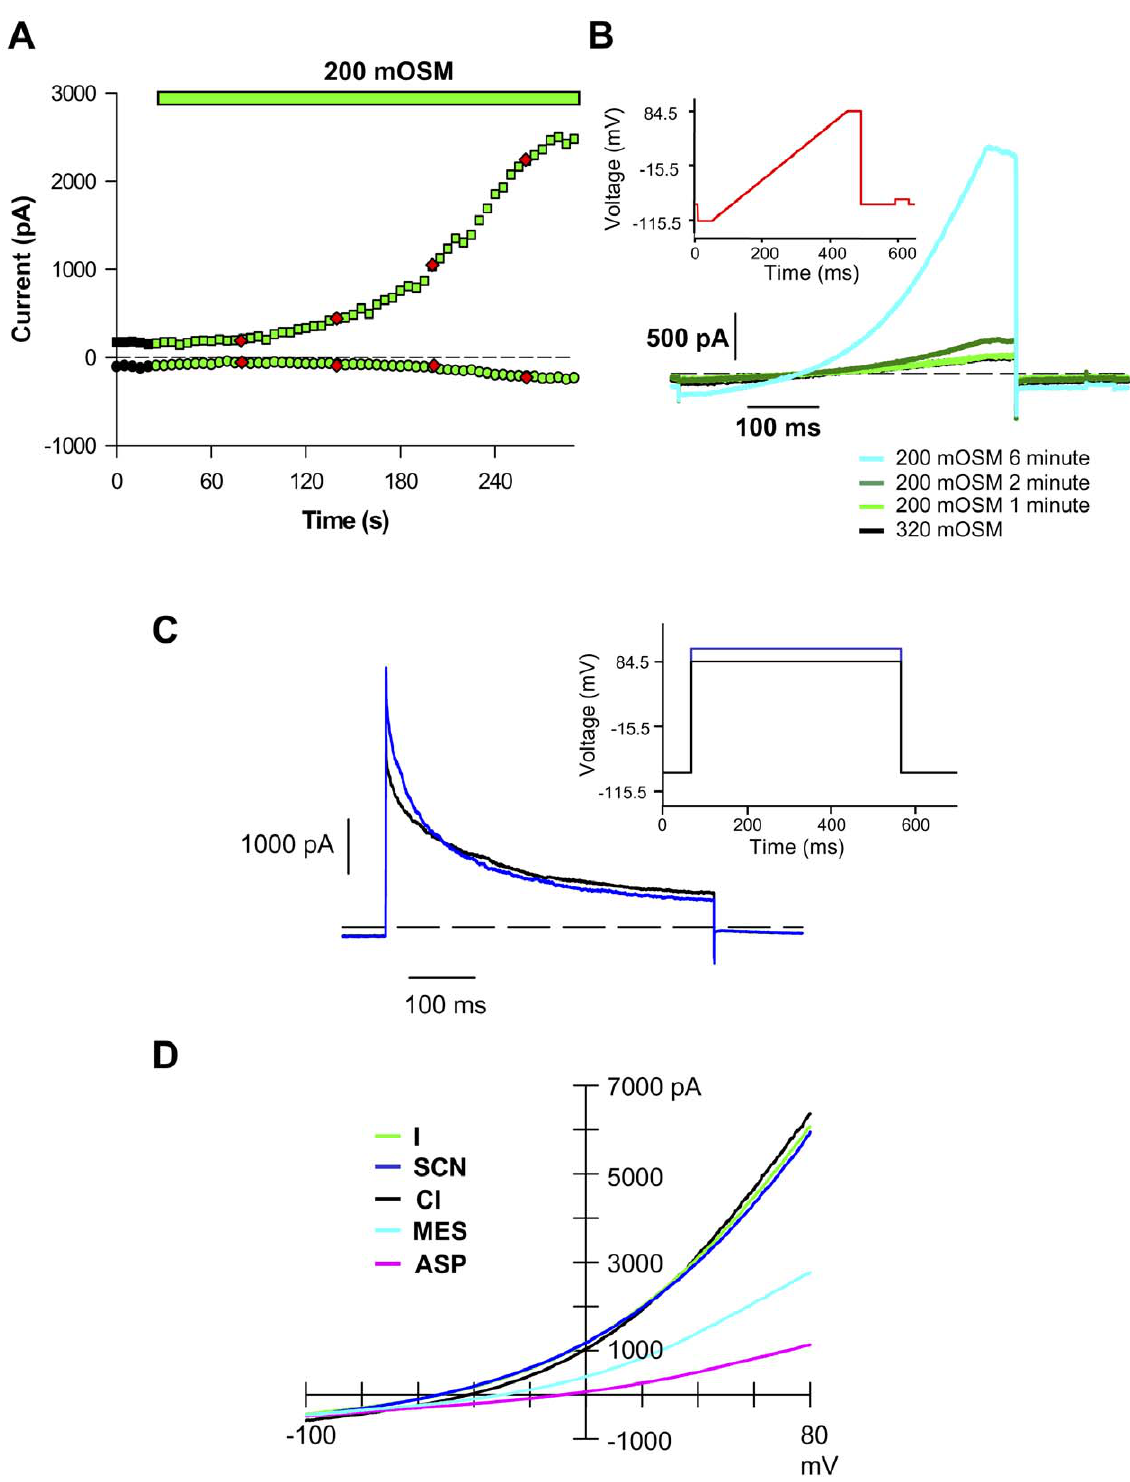
Figure 6. The endogenous HEK cell I Clswell has characteristic mammalian I Clswell properties. ( A ) HEK cell I Clswell develops slowly, reaching steady state after 5 min exposure to 200 mOSM solution. X indicate min in 200 mOSM. ( B ) Ramp protocol (inset) assessment of the HEK I Clswell . Little I Clswell has developed after 2 min in 200 mOSM solution. The steady state I Clswell is outwardly rectifying and inactivating at positive potentials. No tail currents are apparent. ( C ) Step protocol (inset) assessment of the HEK I Clswell . Rapid inactivation is observed at positive potentials. No tail currents are apparent. ( D ) Relative permeability and slope conductance sequences for the endogenous HEK I Clswell are SCN=I . Cl .. MES . ASP vs SCN=I=Cl .. MES . ASP.